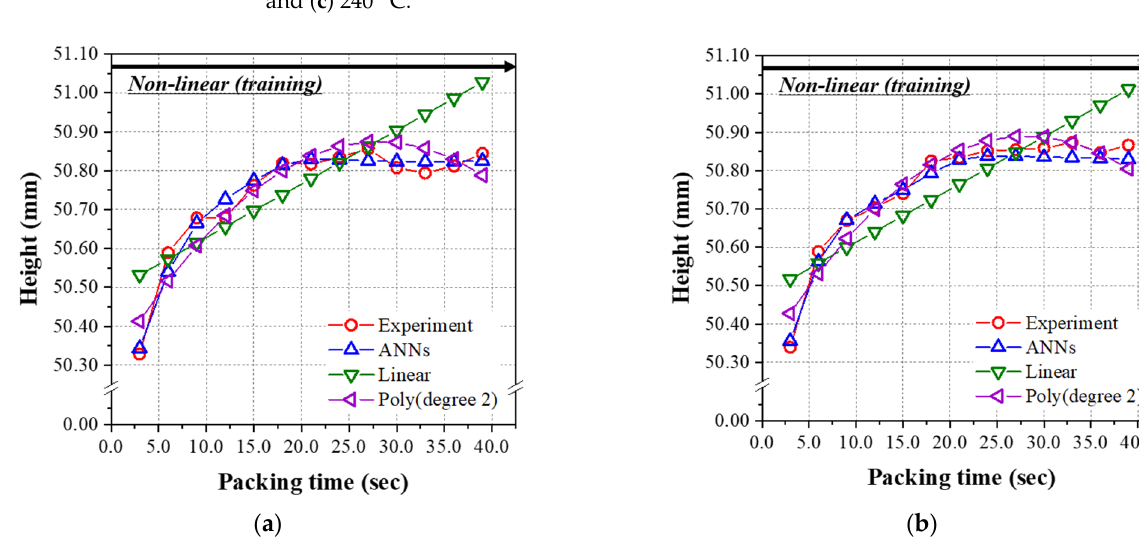
Figure 13. Predicted diameters of the nonlinear group from Table A2 using the models learned by the nonlinear group (packing time was 3.0–39.0 s). Melt temperatures were ( a ) 200 °C, ( b ) 220 °C, and ( c ) 240 °C.